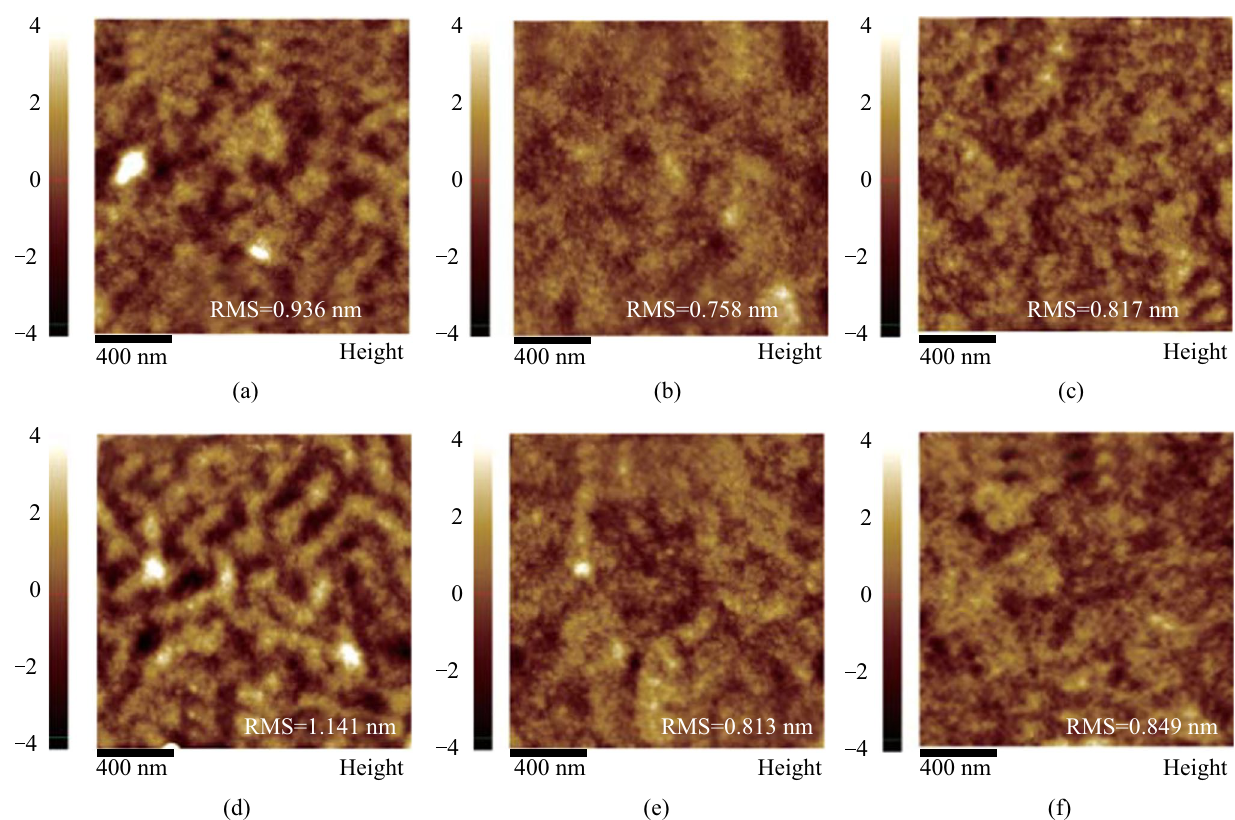
Fig. 7 AFM images for films of a PDI-1:PTB7-Th, b MAS-5:PTB7-Th, c MAS-7:PTB7-Th, d PDI-1:PDX, e MAS-5:PDX, and f MAS-7:PDX